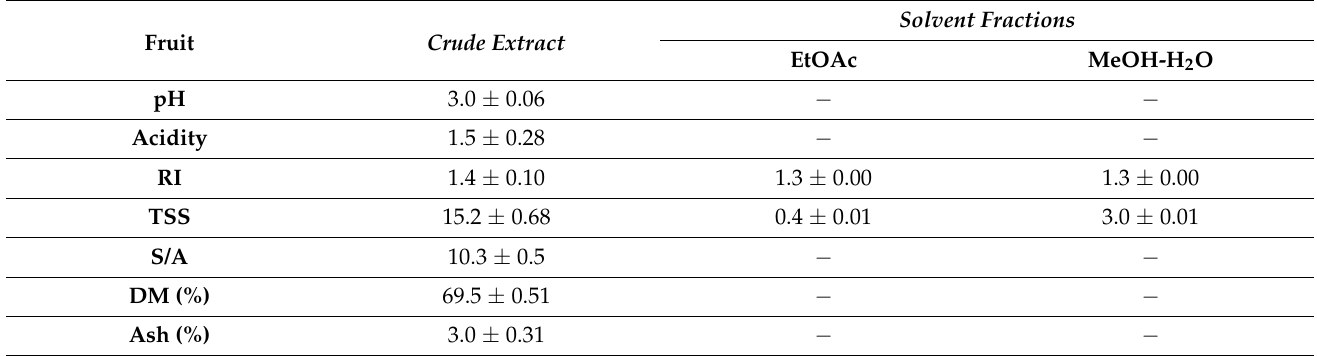
Table 1. Physico-chemical parameters of C. humilis fruit samples. The results are expressed as mean ± standard deviation. Fruit Crude